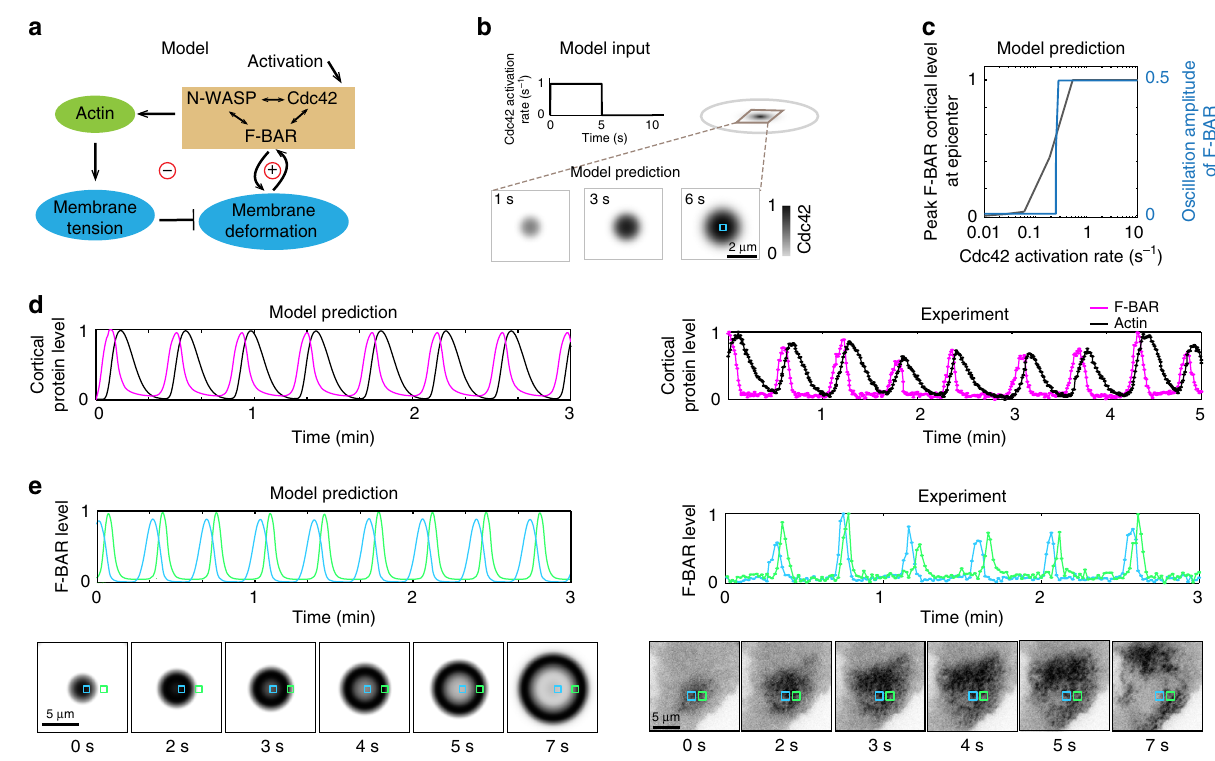
Fig. 1 Cortical protein oscillation underlies wave initiation and propagation. a Key model components and their interactions. b Model prediction that a localized GTP-Cdc42 pulse results in nucleation of a cortical patch. In the simulation shown, this external activation was transient, i.e., after 5 s it was turned off for the rest of the simulation. Top: temporal and spatial pro fi les of the initial Cdc42 activation. Bottom: spatial-temporal evolution of Cdc42 cortical density. c Model prediction that oscillation of cortical protein requires a threshold activation level. d Local cortical protein oscillation during wave propagation. Left: the model prediction of the time curves of F-BAR and actin oscillation at the epicenter, indicated by a cyan box in Fig. 1b, bottom. Right: experimental results show similar oscillations of cortical proteins. e Characteristics of wave propagation. Left: model prediction. Right: experimental measurement. Top: stable phase shift in the cortical oscillation between neighboring areas. The locations are marked by blue squares and green squares in the corresponding cases, in which they are 2.5 μ m apart in model result (left bottom) and 2.88 μ m apart in experiment (right bottom). The two ROIs are chosen to show that oscillations at the different locations have a stable phase shift, a feature that holds for any two ROIs along the direction of wave propagation. Bottom: snapshots of F-BAR cortical density pro fi les over time. For the model result, the time is relative to when the transient Cdc42 activation stops in Fig. 1b. In the experiment, the F-BAR level is the FBP17 fl uorescence intensity minus background fl uorescence, normalized by